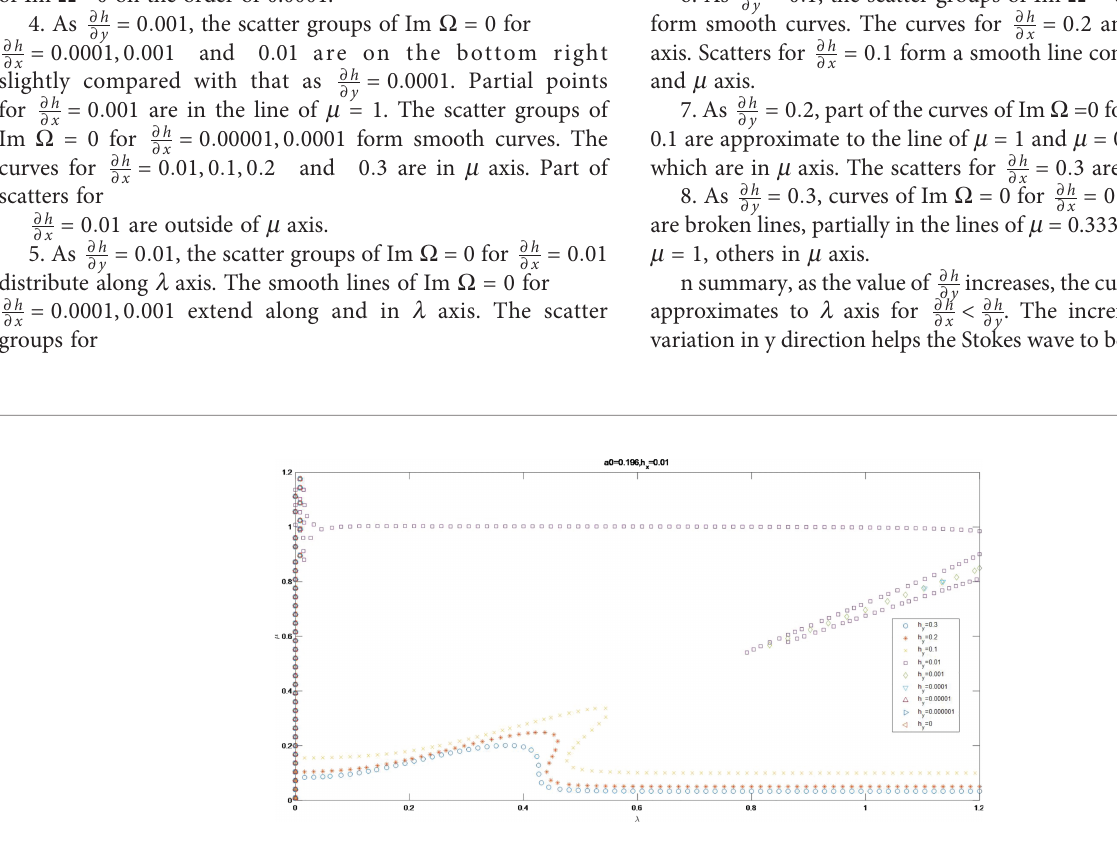
FIGURE 10 | The magni fi ed curves of Im W = 0 for a 0 = 0.196 and ∂ h ∂ x = 0 :